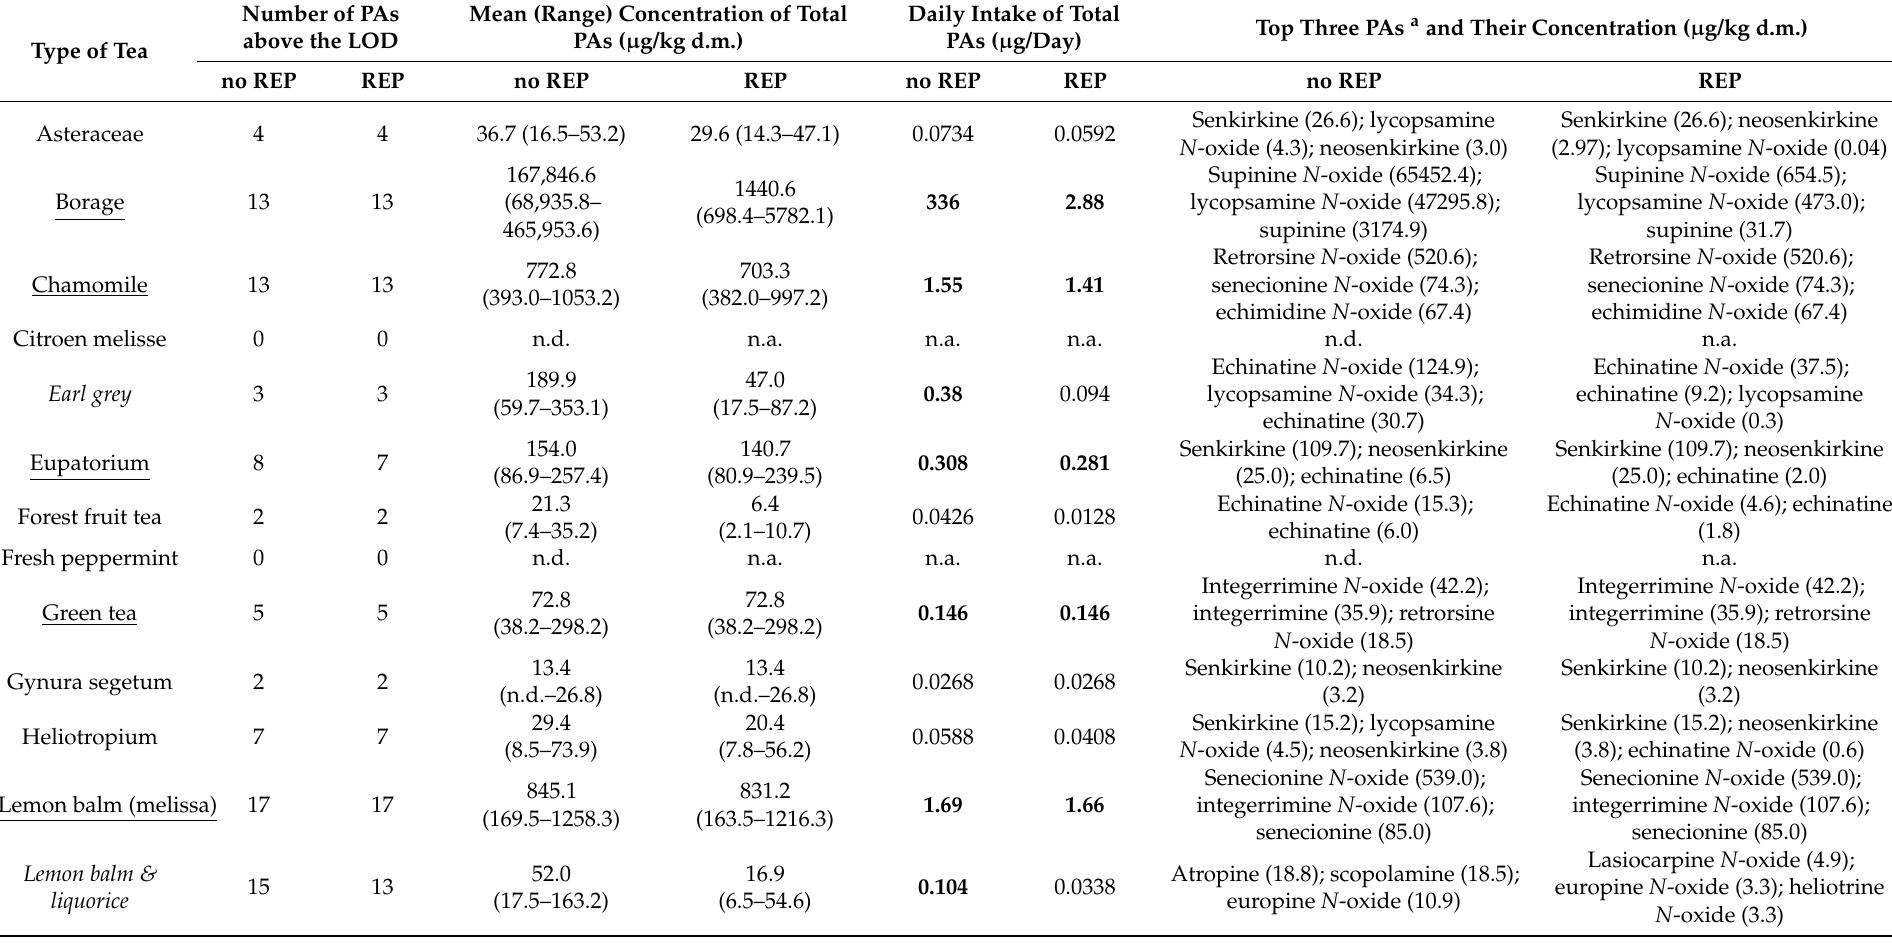
Table 2. Total number of detected PAs, total PA levels, daily intake of total PAs when consuming 2 g of tea and the top three PAs and their concentration in 21 types of (herbal) teas with and without REP correction. A complete data overview is shown in supporting data